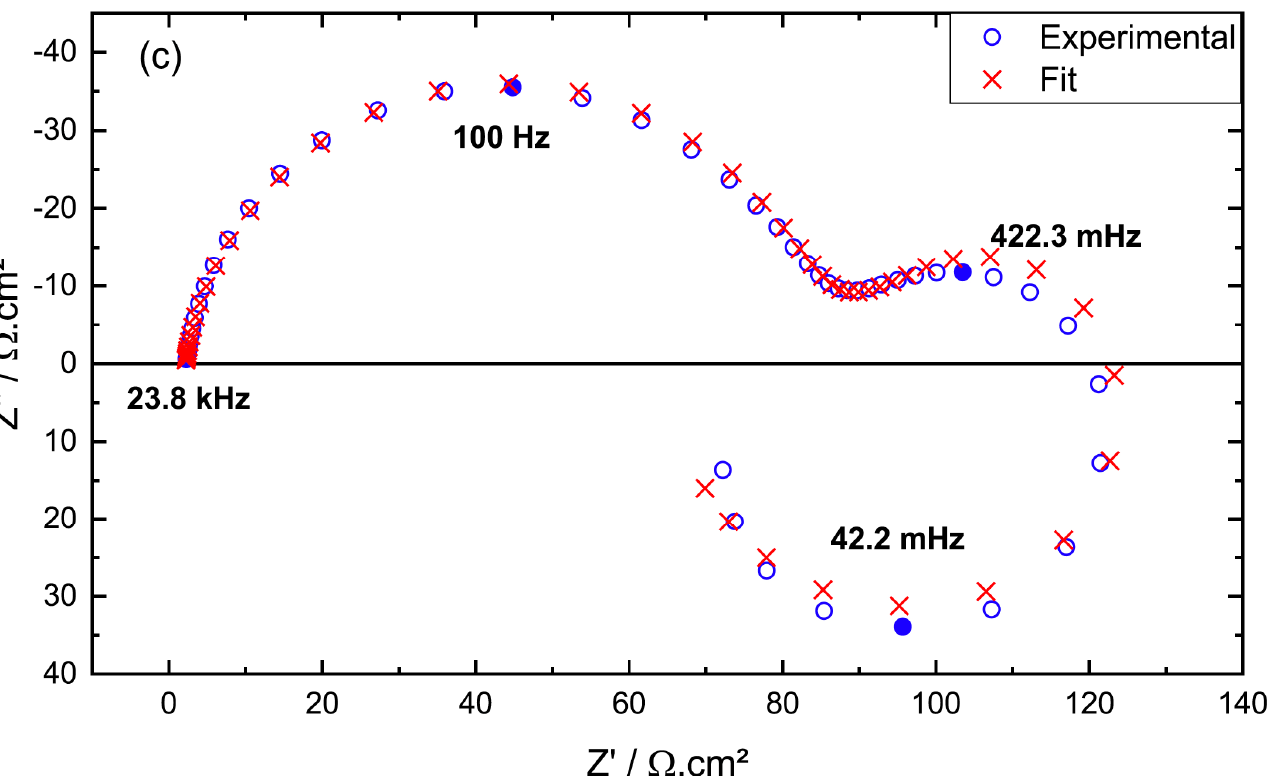
Figure 19. Experimental impedance diagrams [45] for a rotating disc Mg electrode (1000 revolutions per min) after 30 min at the corrosion potential in 1 M Na 2 SO 4 (open circles) and the result of the fitting procedure with a Mg corrosion model based on the uni-positive Mg + ion (crosses) at ( a ) pH = 1.8, ( b ) pH = 2.9, and ( c ) pH = 7.7. The good fit between the Mg corrosion model based on the uni-